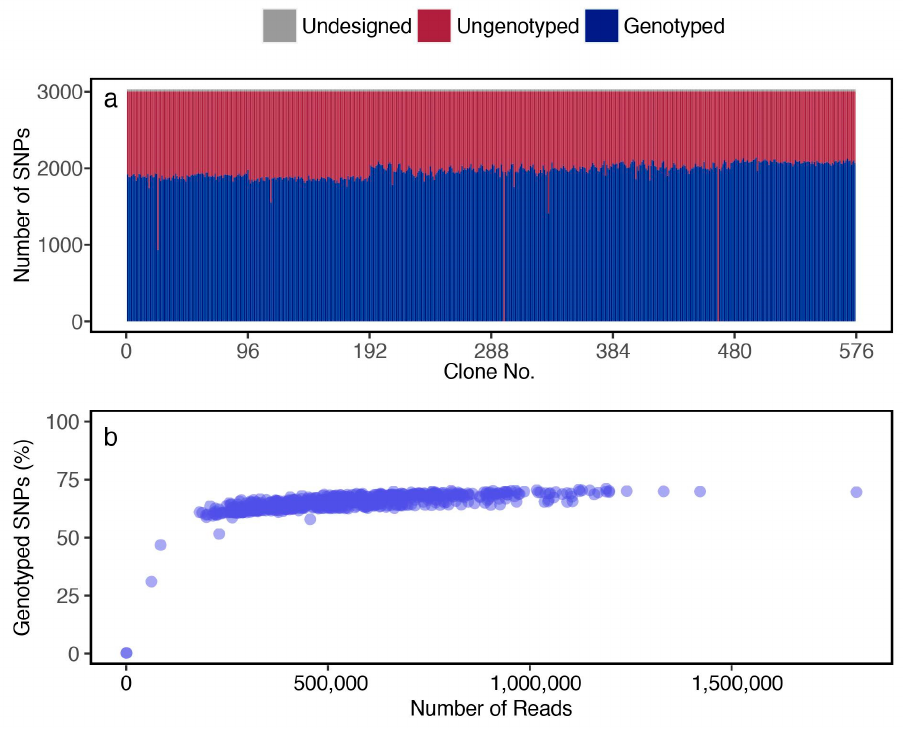
Figure 4. For genotyping the F 1 population, ( a ) number of SNPs detected by AmpliSeq; and ( b ) relationships between read count per sample and genotype call rate.